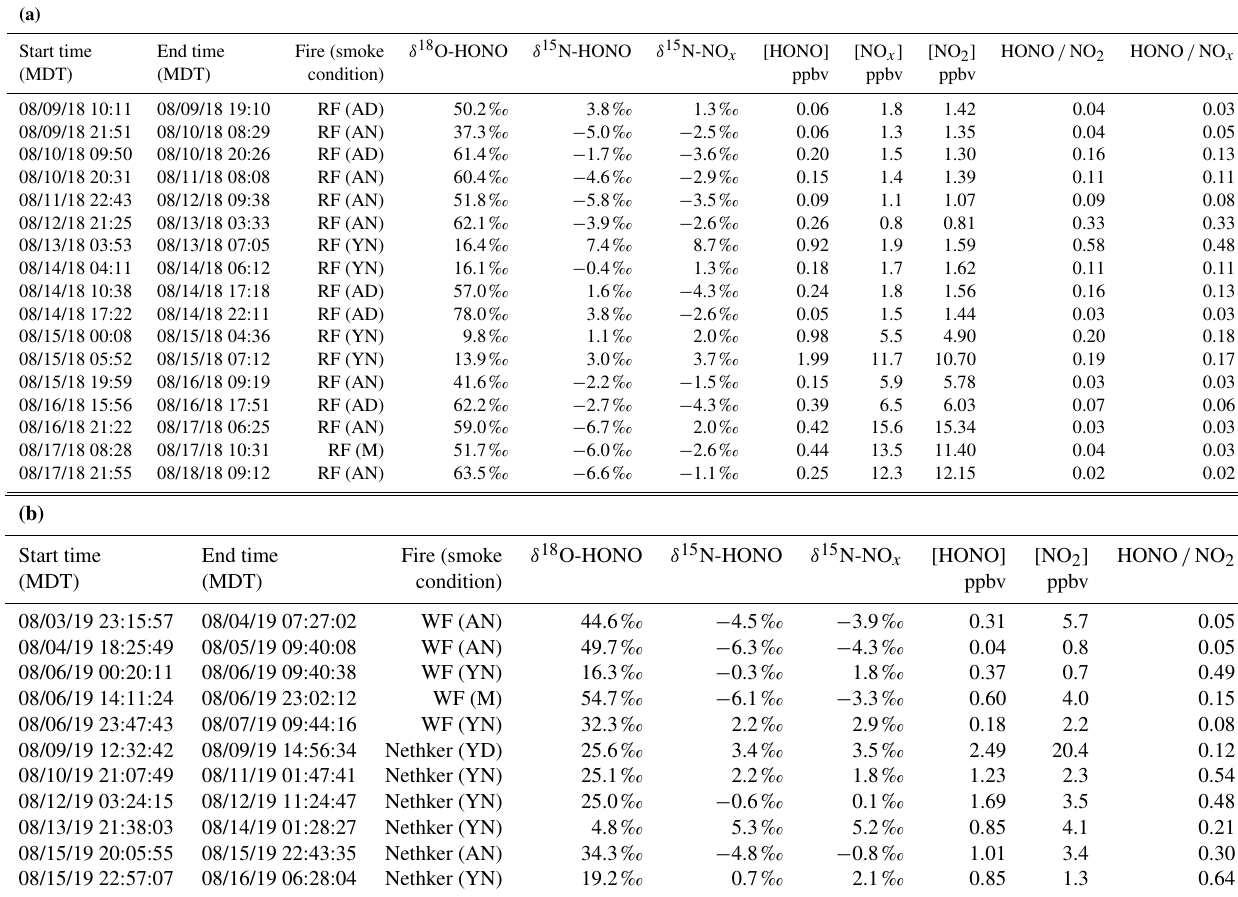
Table 1. Sampling condition and isotopic composition and concentration results for NO x and HONO for Rabbit Foot (RF) fire during the 2018 WE-CAN campaign (a) , as well as Williams Flats (WF) fire and Nethker fire during the 2019 FIREX-AQ campaign (b) . Smoke conditions include young nighttime smoke (YN), young daytime smoke (YD), mixed daytime smoke (MD), aged nighttime smoke (AN) and aged daytime smoke (AD). The conditions are determined primarily by comparing the field data with the lab data involving three factors: δ 18 O-HONO, δ 15 N relationship between HONO and NO x , and HONO / NO x (or HONO / NO 2 ) ratio, along with the smoke sampling locations. Specifically, significantly elevated δ 18 O-HONO indicates secondary production of HONO. Note that during the 2019 campaign, NO x concentrations were not measured due to instrumental